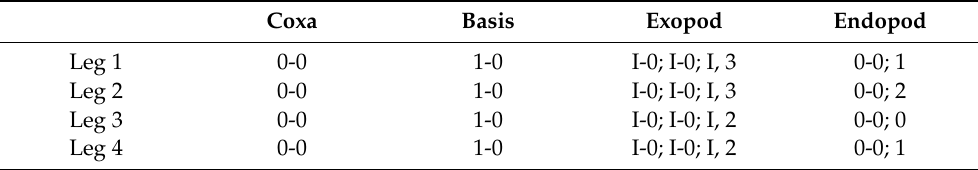
Figure 4. Xarifia yanliaoensis sp. nov. female. antenna ( A ); mandible ( B ); maxillule ( C ); maxilla ( D ); maxilliped ( E ); other face of maxilliped ( F ). Scale bars: ( A – F ) = 0.025 mm. Legs 1–4 (Figure 5A–D) each with 3-segmented exopod, 2-segmented endopod. The shape and armature of leg 2 as in leg 1, but endopod of leg 2 armed with 2 setae (instead of 1 seta). Exopods of legs 3 and 4 similar to legs 1 and 2, but 2 setae only (instead of 3 setae) on the terminal segment. Endopod of leg 3 unarmed. Endopod of leg 4 bearing with 1 seta. Formula of spines (Roman numerals) and setae (Arabic numerals) as follows: